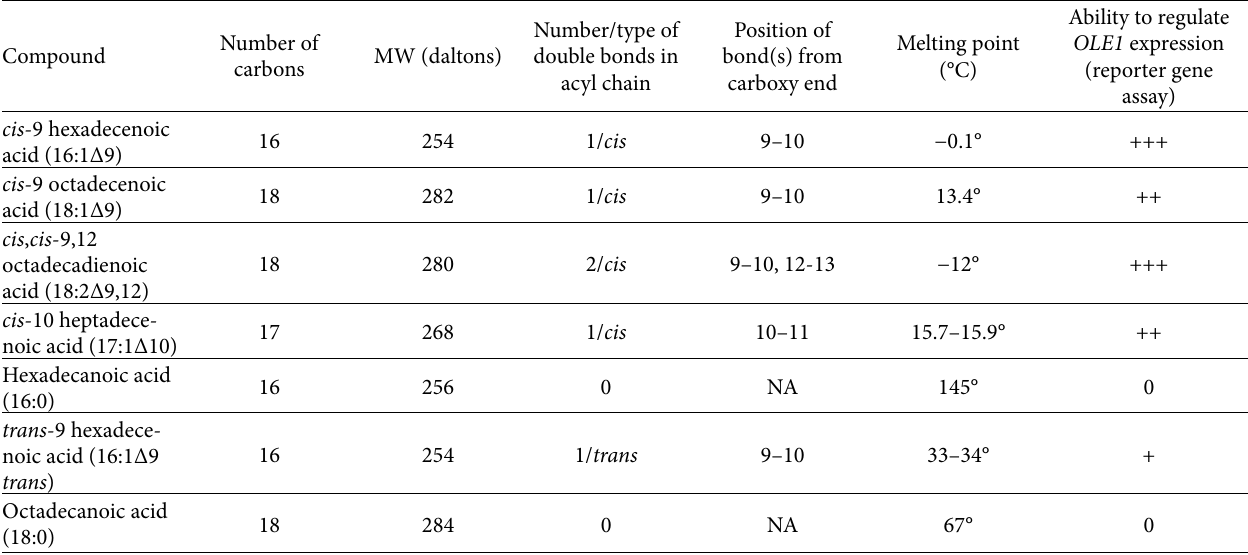
Table 1: Correlation of physical and structural properties of the fatty acids used in this study with regulatory effect on OLE1 . For most fatty acids, the melting points were as reported [35]. The melting point of cis -10-heptadecenoic acid was determined as described in Section 2.